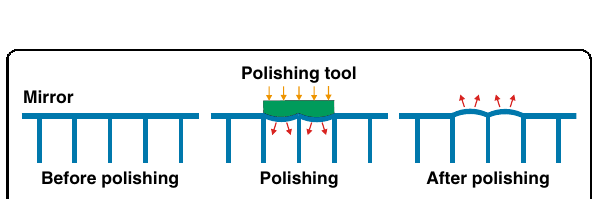
Fig. 12 Schematic of the "print-through" effect produced by polishing with large tools. Mirrors with a lightweight structure are subject to “ print through ” or “ quilting ” effect under large tool lapping